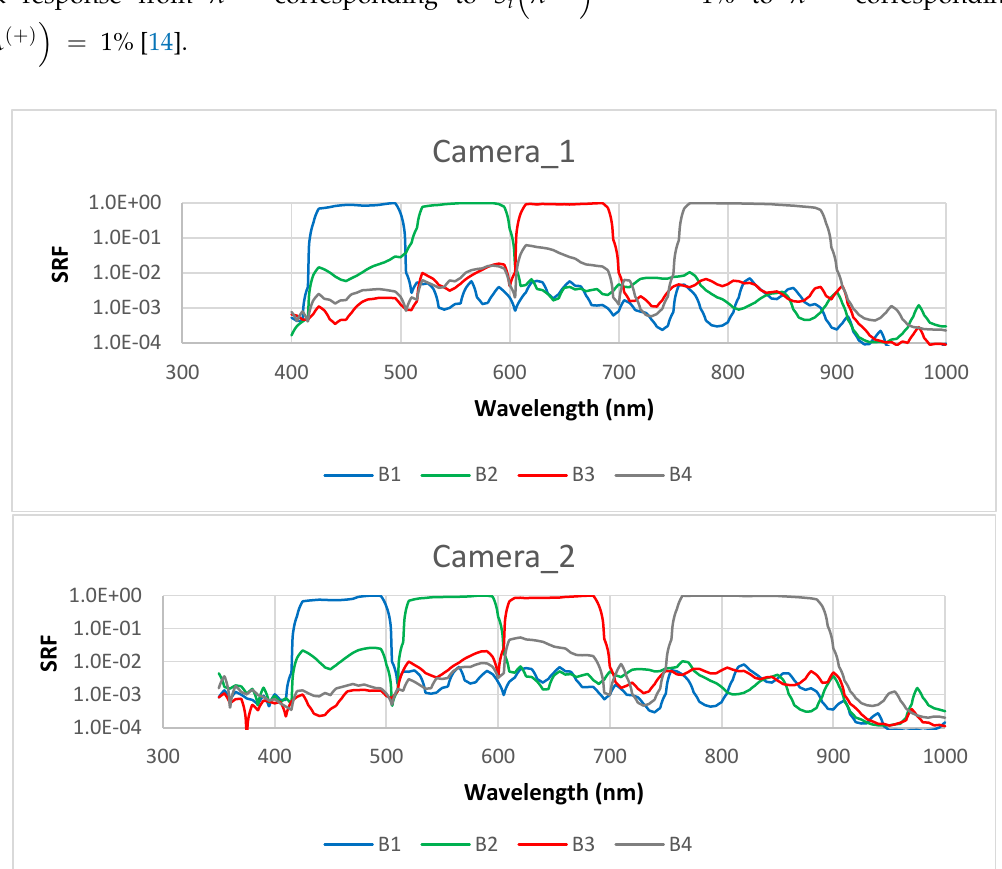
Figure 3. Spectral response functions (SRF, in arb. units) of the two cameras of CZI. The CZI’s wide swath of 950 km is achieved by mosaicking the images acquired by the two cameras, each having 32° field of view, with 1° overlapping.